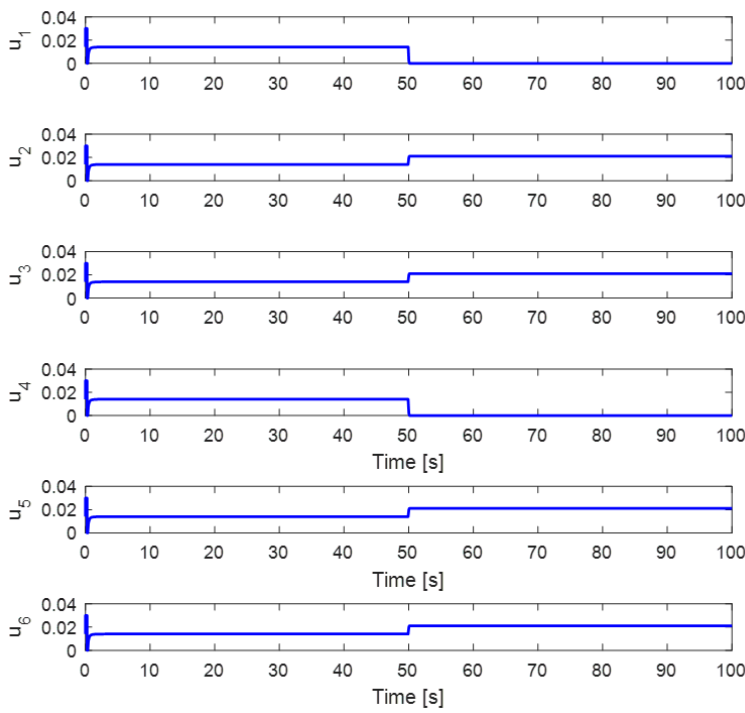
Figure 10. Response of motor’s command with simultaneous fault.